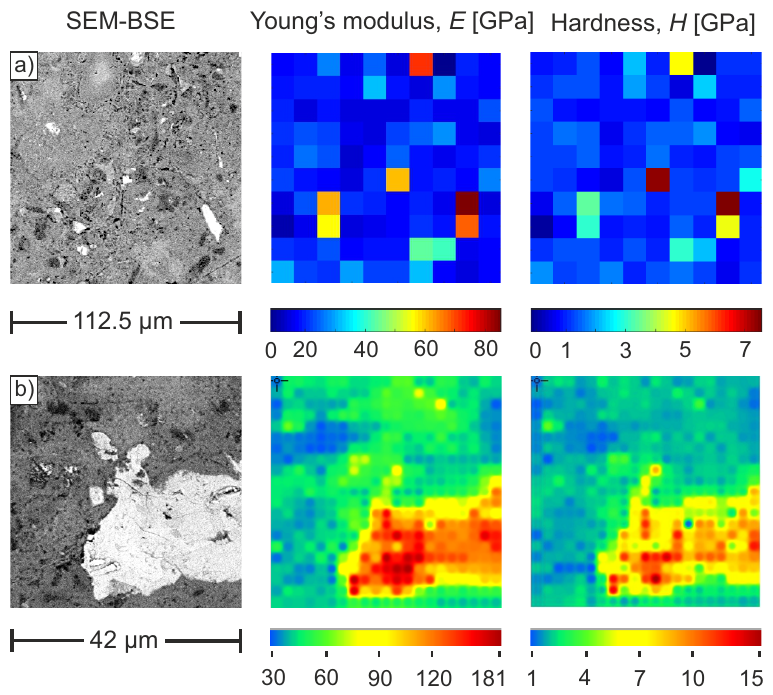
Figure 2. SEM-BSE image, Young’s modulus, Hardness maps measured by a) NI b) XPM.